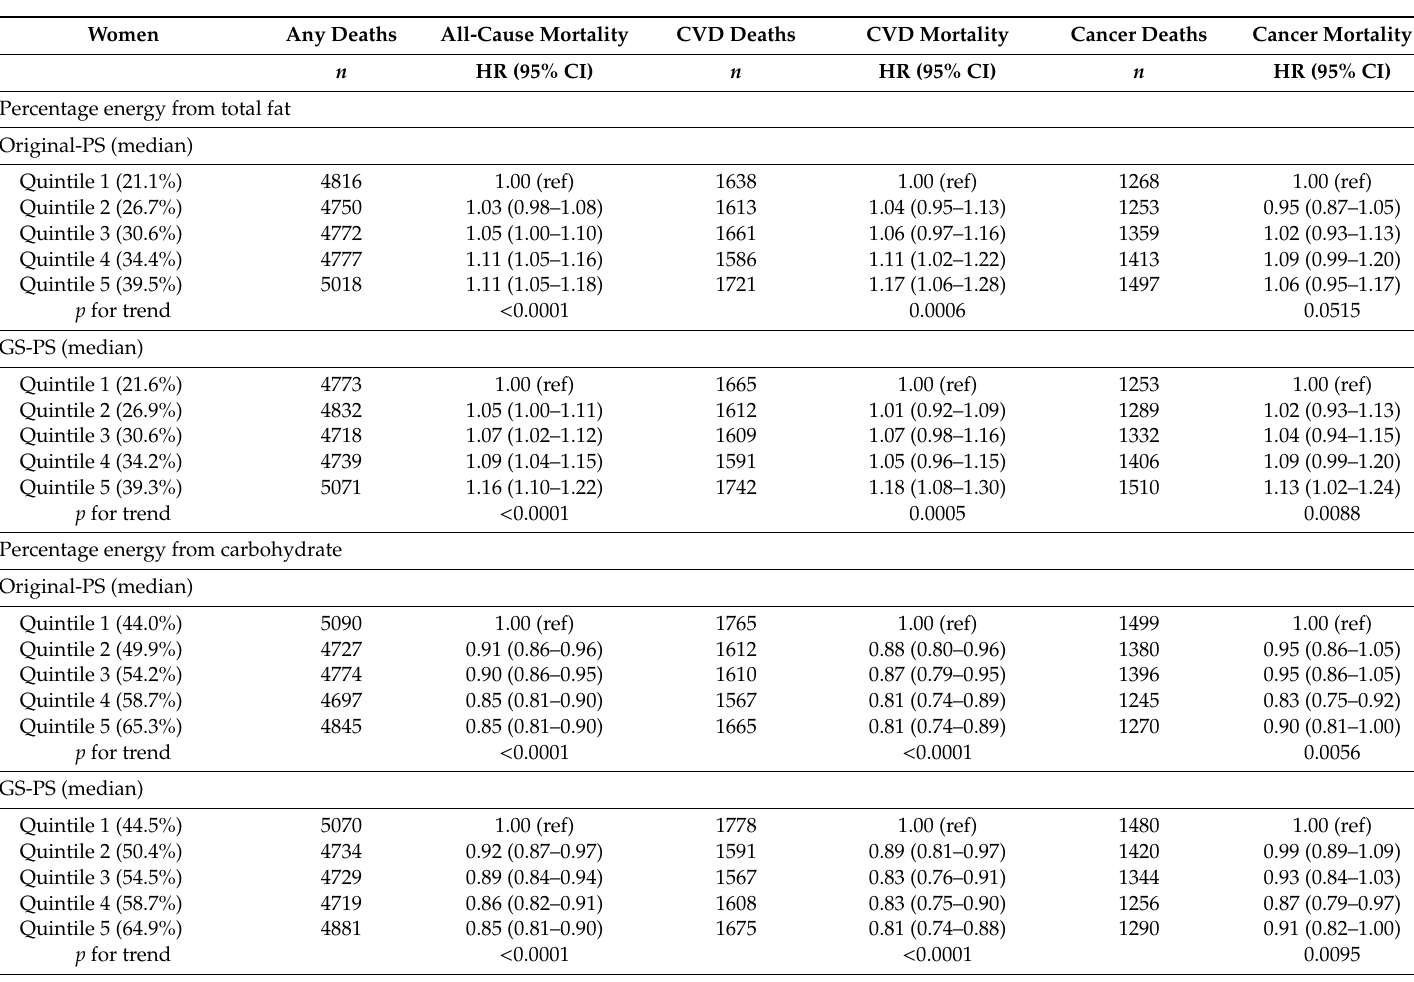
Table 5. Hazard ratios (HRs) (95% confidence intervals (CIs)) for all-causes, cardiovascular disease (CVD), and cancer mortality according to quintiles of percentage energy from macronutrients estimated from a food frequency questionnaire either using an original portion size (Original-PS) or a gender-specific portion size (GS-PS) among women ( n = 86,292) in the Multiethnic Cohort Study, 1993–2014 1